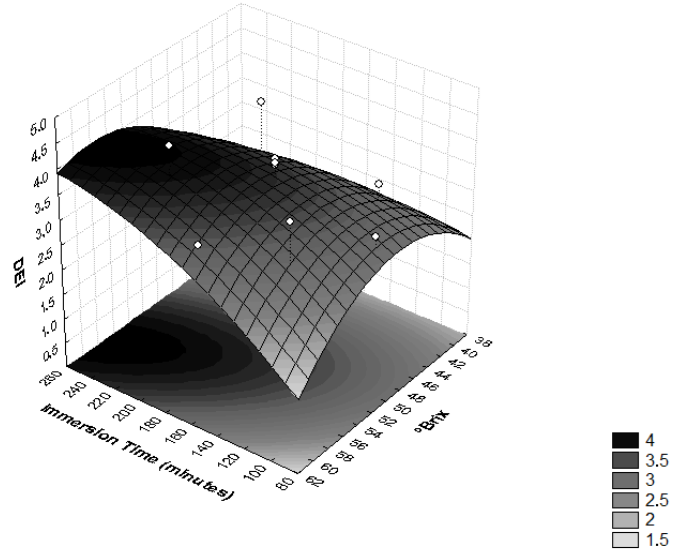
Figure 4. Surface response for the Dehydration Efficiency Index (DEI) as a function of immersion time (minutes) and the concentration of sucrose solution (°Brix).